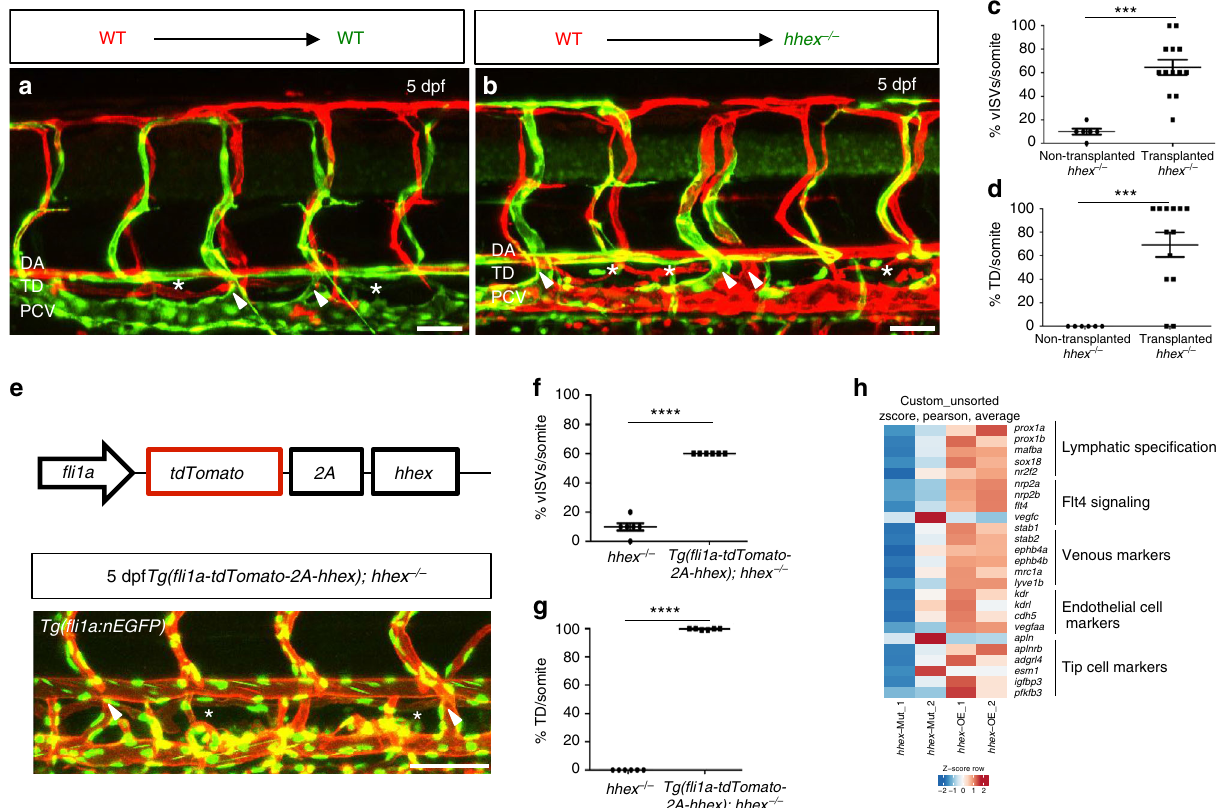
Fig. 4 Hhex is required cell-autonomously in endothelial cells to promote venous and lymphatic sprouting in zebra fi sh. a , b Transplantation of Tg( fl i1ep: DsRedEx) donor cells into TgBAC(etv2:EGFP) hosts derived from hhex + / − incrosses. Wild-type endothelial cells contribute to arteries, veins, and lymphatics in wild-type sibling ( a ) and mutant ( b ) hosts at 5 dpf (arrowheads point to vISVs; asterisks indicate TD). c , d Quanti fi cation of vISVs ( c ) and TD extensions ( d ) across four somites in hhex − / − larvae with transplanted wild-type cells ( n = 13) vs. hhex − / − larvae without transplanted wild-type cells ( n = 6) at 5 dpf. Wild-type endothelial cells can partially rescue both vISV and TD formation in hhex − / − . e hhex endothelial overexpression strategy using the fl i1a promoter partially rescues the hhex − / − vascular phenotype (arrowheads point to vISVs; asterisks indicate TD). f , g Quanti fi cation of vISVs ( f ) and TD ( g ) extensions across four somites in hhex − / − ( n = 6) and Tg( fl i1a:tdTomato-2A-hhex); hhex − / − ( n = 6). h RNA sequencing of 48 hpf FACS-sorted hhex − / − endothelial cells and hhex -overexpressing endothelial cells. Heat map comparisons between these datasets identify Hhex as a regulator of genes implicated in lymphatic speci fi cation ( prox1a , prox1b , mafba , sox18 , nr2f2 ) and Flt4 signaling ( nrp2a , nrp2b , fl t4 , vegfc ) while endothelial cell markers are modulated only by endothelial-speci fi c hhex overexpression. Values represent means ± s.e.m. **** P ≤ 0.0001 and *** P ≤ 0.001 by t -test. Scale bars: 50 μ